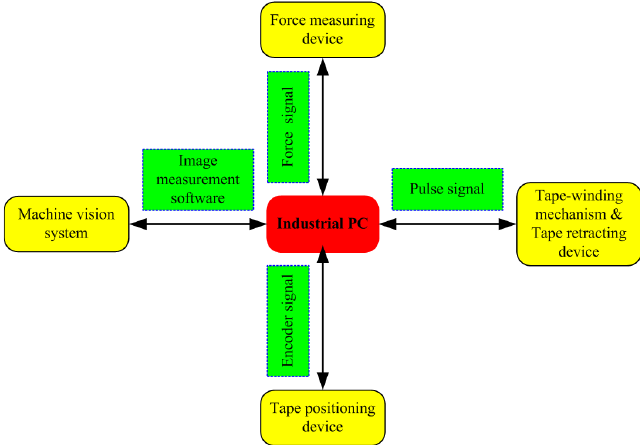
Figure 2. Control principle of the